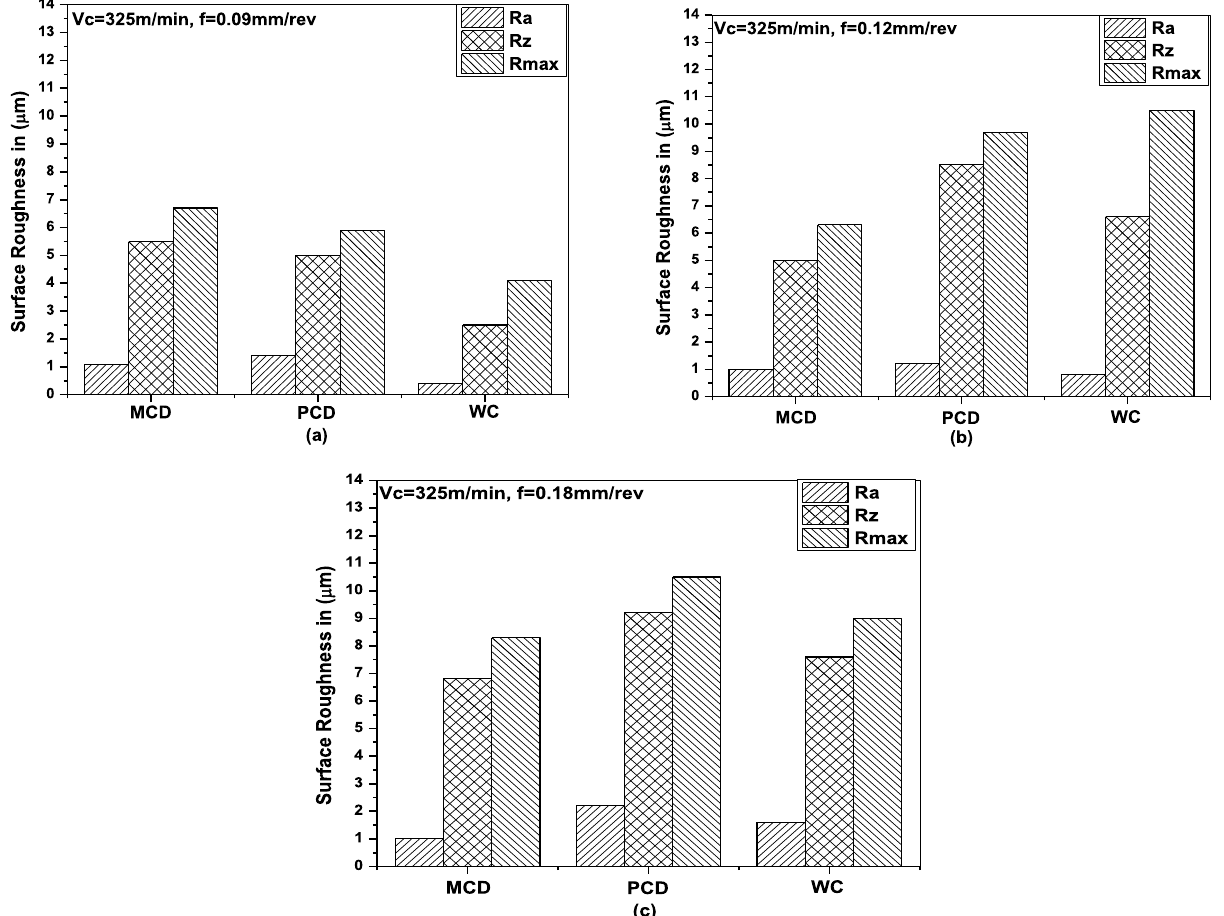
Fig. 18. Graph representing the roughness values ( Ra , Rz , R max ) for different tools at constant velocity of 325 m/min and varying feed, (a) Feed = 0.09mm/rev, (b) Feed =0.12 mm/rev and (c) Feed =0.18 mm/rev.